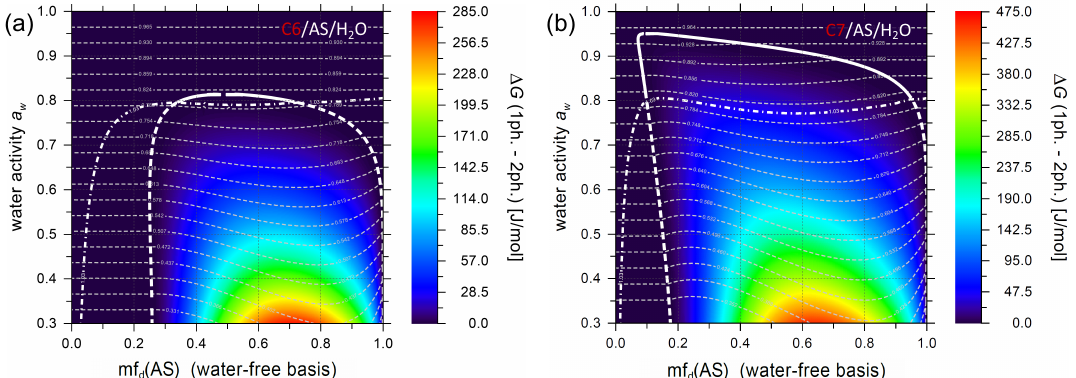
Fig. 9. Calculated Gibbs energy difference 1 G (color bar), between a hypothetical one-liquid-phase state (1ph.) and a two-liquid-phases state (2ph.) for (a) the C6/AS/H 2 O and (b) the C7/AS/H 2 O system at 298K. The computed coexistence curves are shown in white (dashed where AS is supersaturated) and correspond to coexistence curves of panels (e) and (h) in Fig. 8. The solubility limit of AS (deliquescence onset) is shown as the white dashed-dotted curve. The light grey dashed lines are isolines of constant equilibrium-state water activity. They represent tie-lines within the LLPS